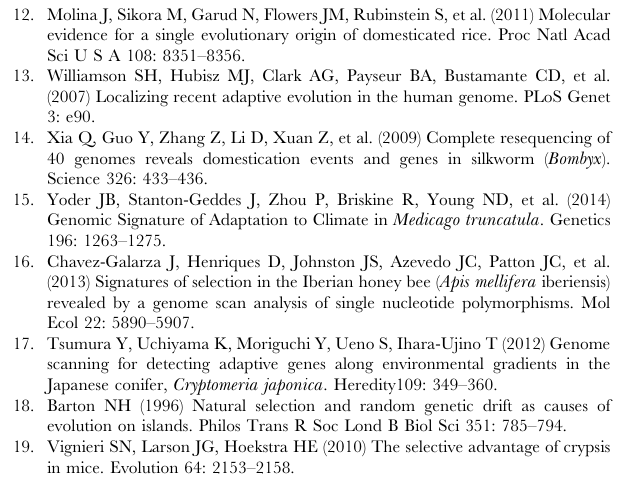
Figure S1 The fraction of simulated replicates rejecting the neutral model by Sweepfinder, with varying sample